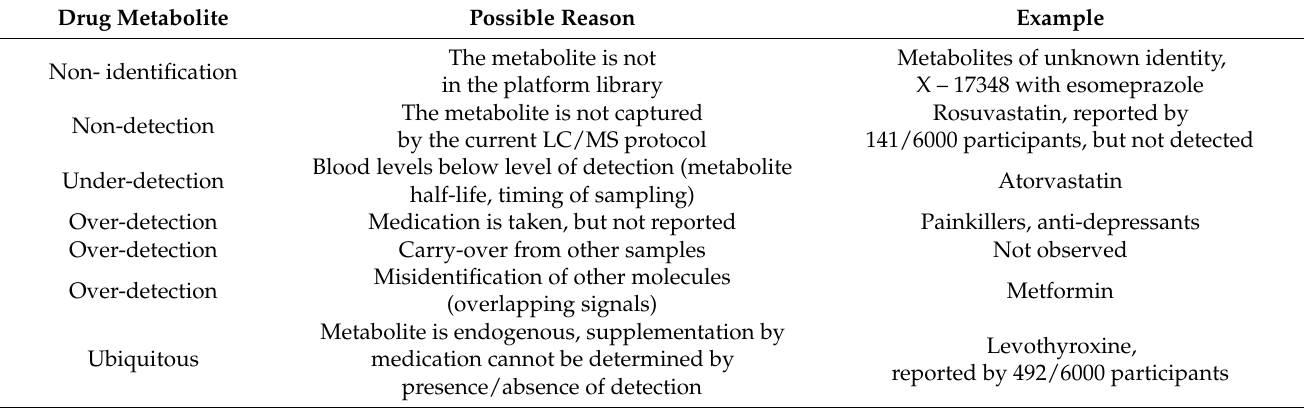
Table 5. Possible reasons for the apparent under- and over-detection of drug